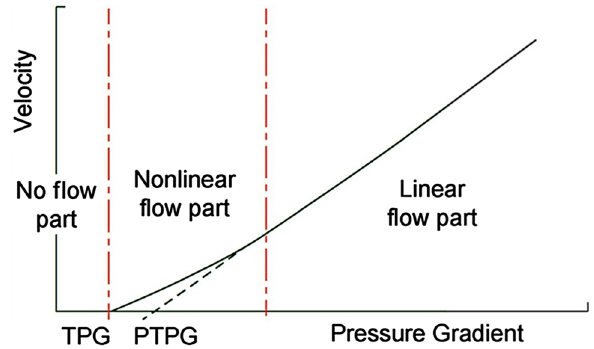
Fig. 1 A typical schematic of low-velocity Non-Darcy flow. (Repro- duced with permission from Huang et al.